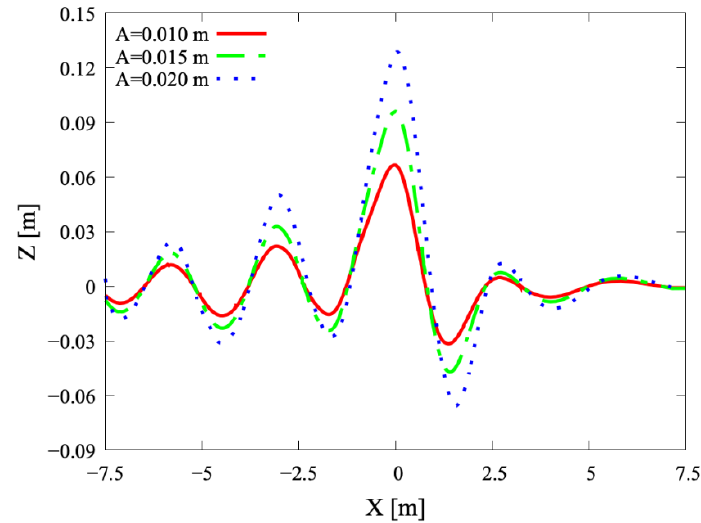
Figure 12. Cross-section of wave profile at focal point along y = 0 m.